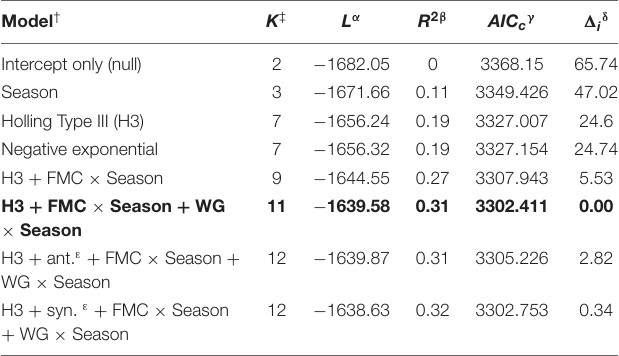
TABLE 5 | Comparison of neighborhood models for prediction of FRED during experimental prescribed fires in longleaf pine woodlands in southwest Georgia, United States (bold font indicates AIC-best model).